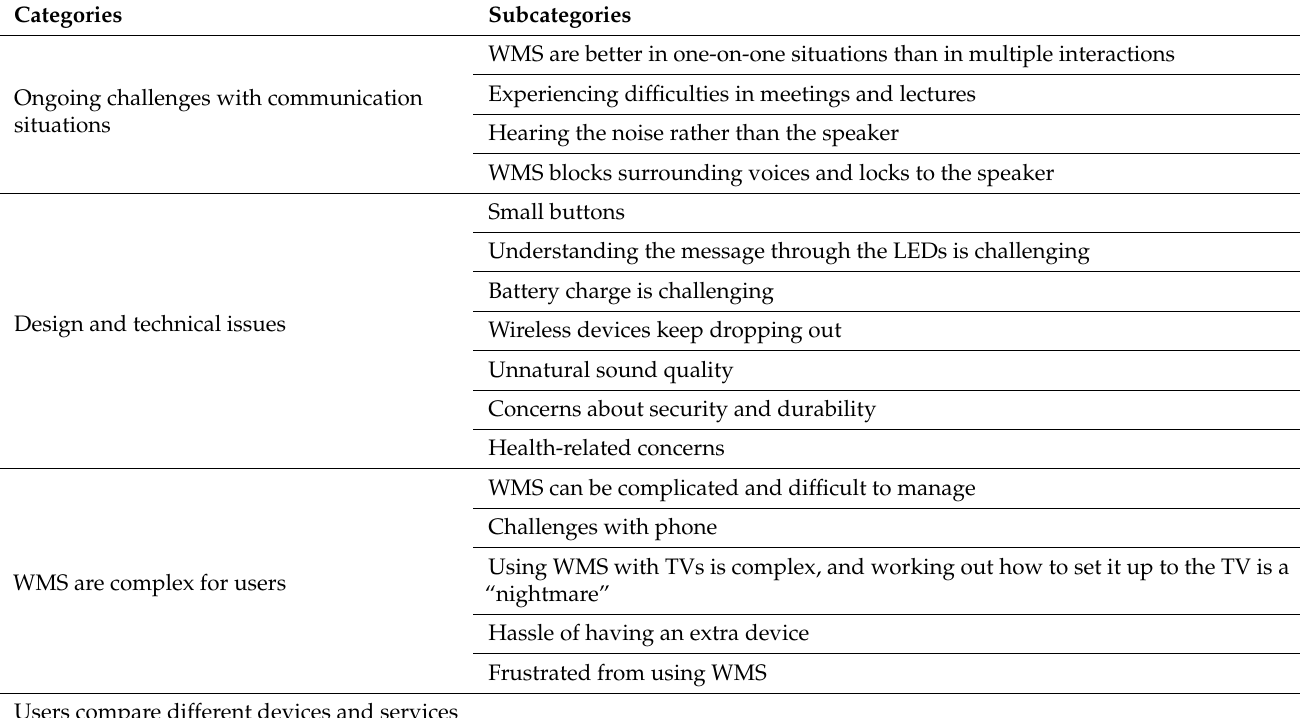
Table 5. Theme 4. Issues with WMS and